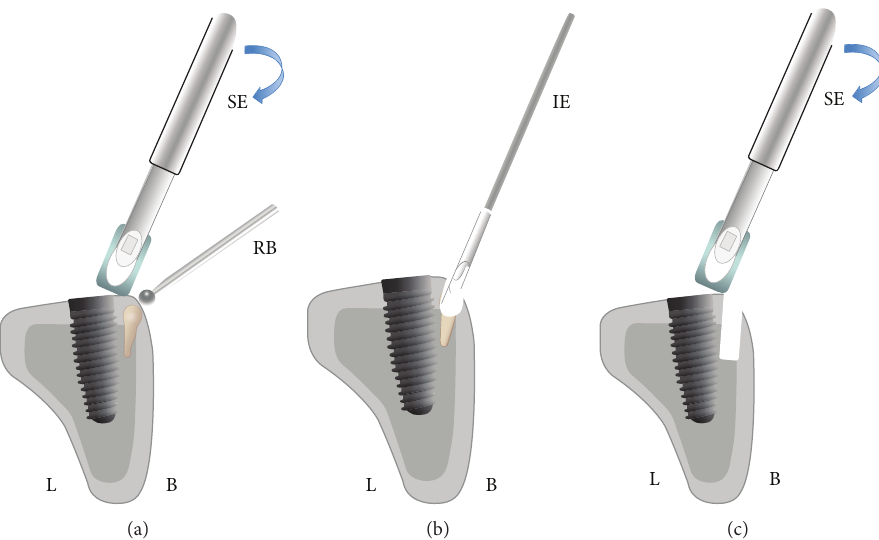
Figure 3: Schematic diagram of supernumerary tooth removal with endoscopic approach. (a) Support endoscopy (SE), an endoscope of 2.7 mm diameter and a 30-degree view angle, with support and irrigation, was used for drilling of the tooth. (b) Immersion endoscopy (IE), an endoscope of 1.9mm diameter, with 30- and 70-degree view angles and continuous irrigation via the support sheath, was used, which permits either short distance observation or up to 40x visualization when there is direct contact with the site by saline solution. (c) Complete elimination of the tooth structure without affecting the bone wall. The bone defect created was inspected with SE. No communication with the implant and buccal bony wall fully retained was observed.